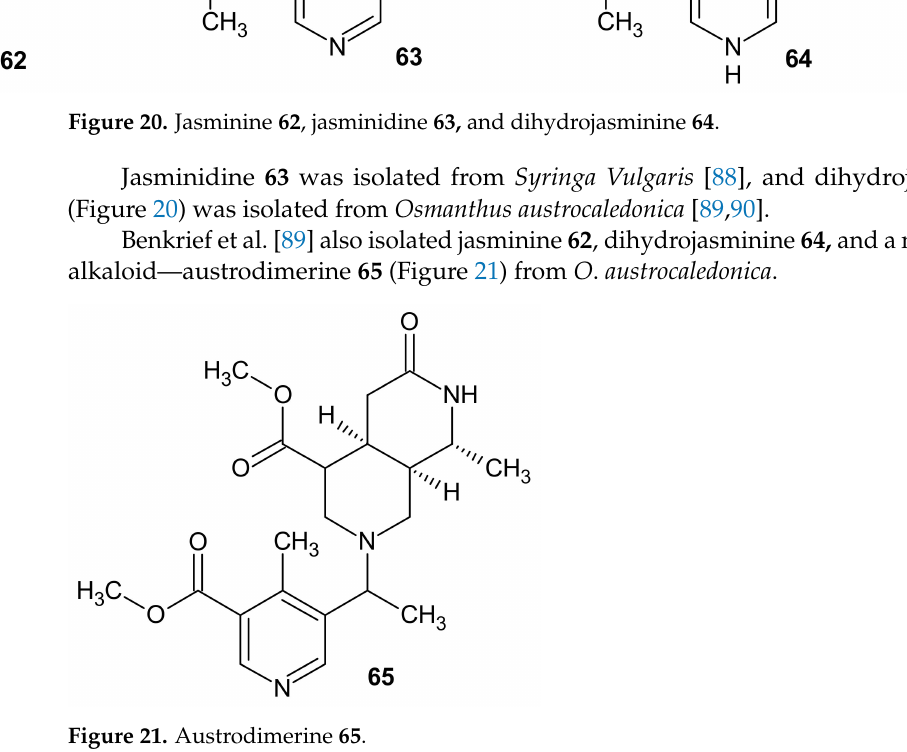
Figure 21. Austrodimerine 65